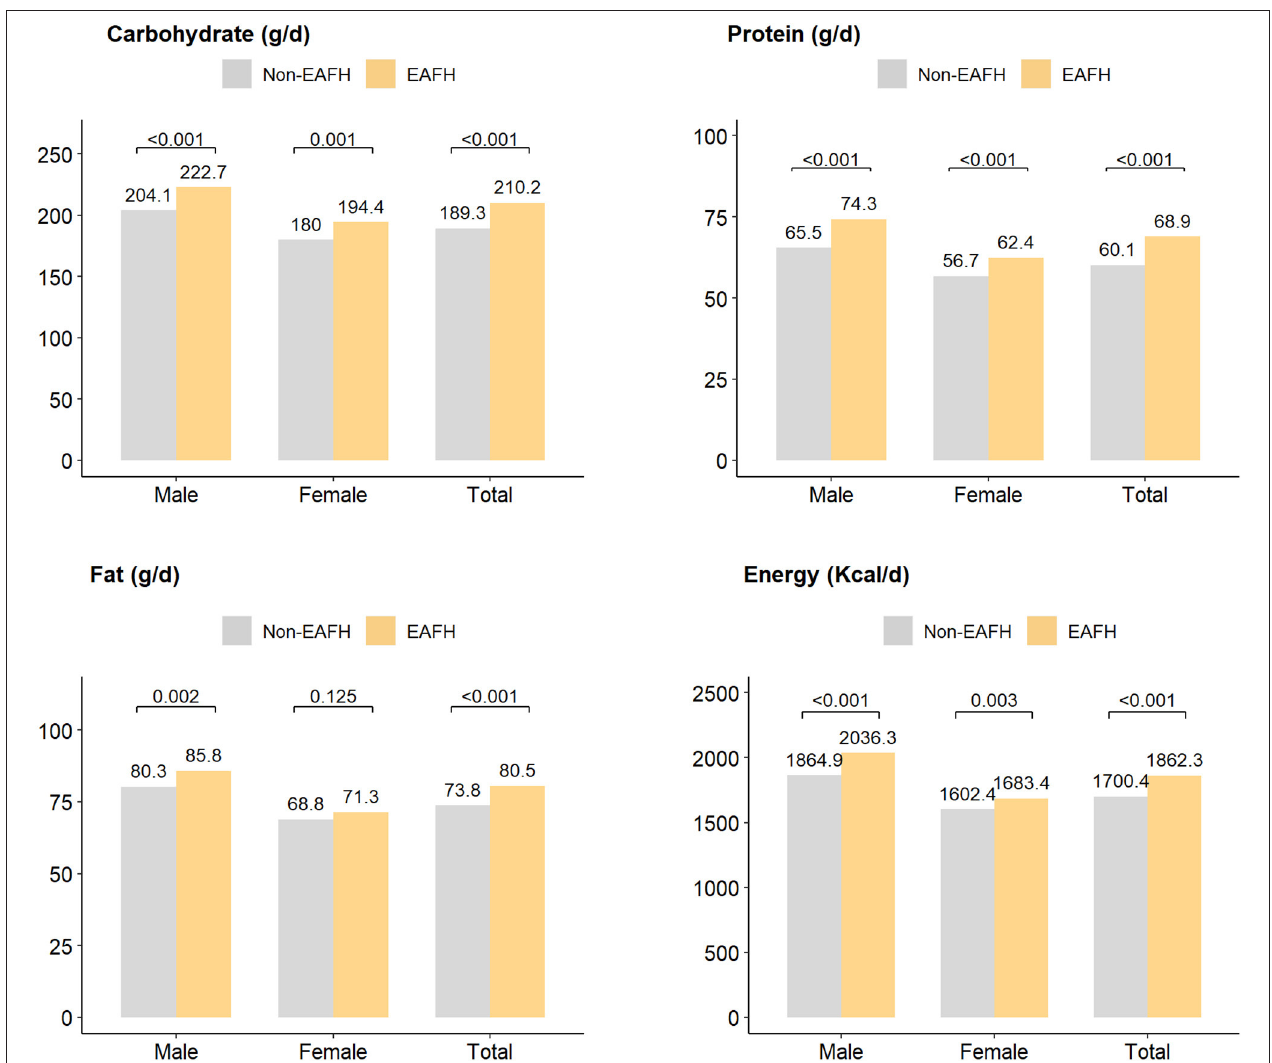
FIGURE 4 | Three major nutrients intake (g/d) and energy intake (Kcal/d) among different populations. EAFH, Eating away from